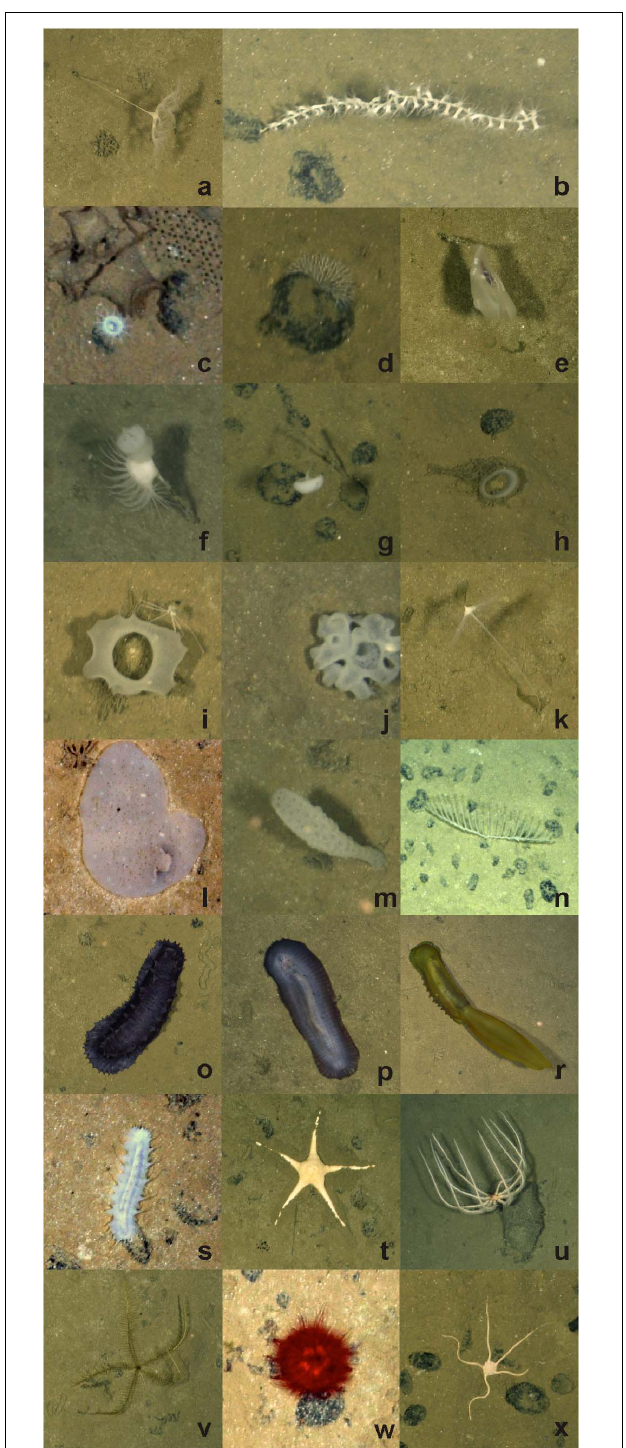
FIGURE 2 | Select invertebrate megafaunal specimens photographed on the abyssal plain in study areas of the western CCZ, with identifications and morphotype codes: (a) Umbellula sp. PEN003, (b) Isididae ALC005, (c) actiniarian ACT022 with large xenophyophore and Paleodictyon trace to top right; (d) Bryozoa BRY002; Ctenophora (e) Lyrocteis sp. CTE010; Porifera